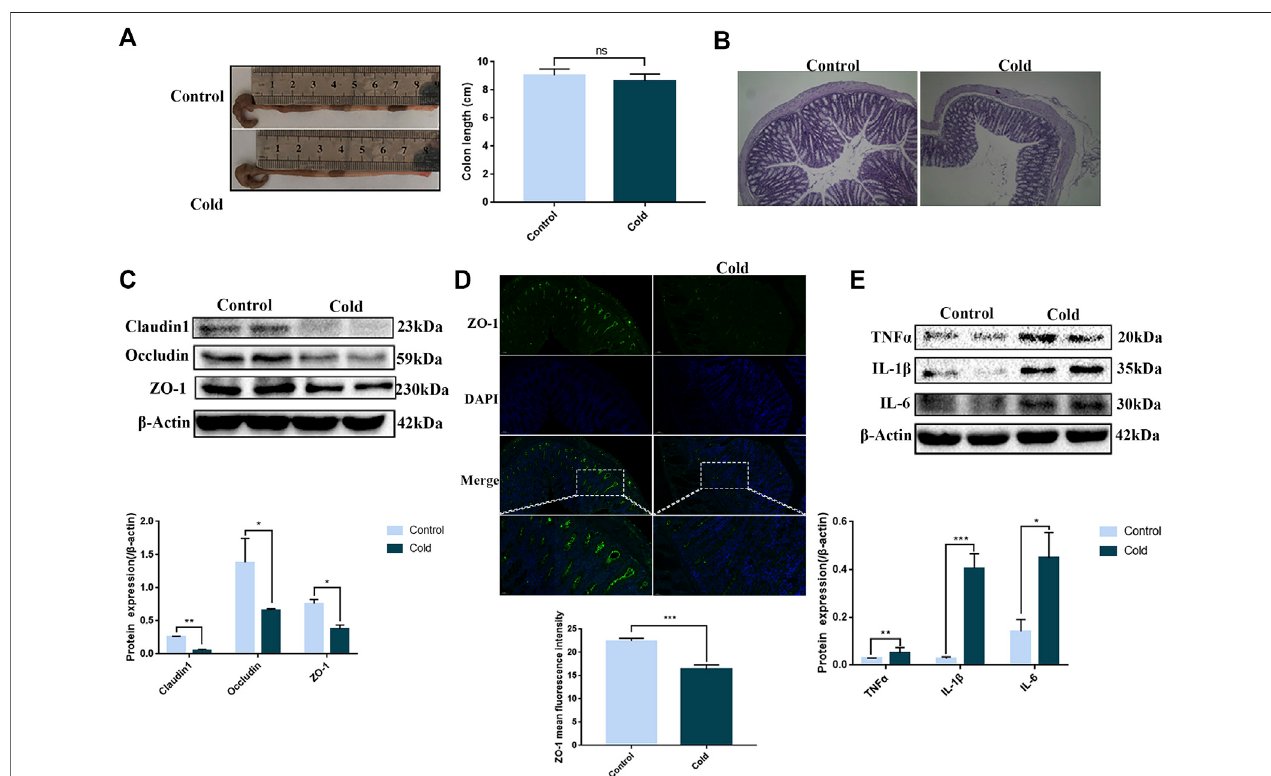
FIGURE1| Coldexposureinducestightjunctiondamageinthecolonandpromotescolonicin fl ammation.Effectsofcoldexposureonmousecolonlength (A) and morphologybyH&Estaining(×100) (B) .Effectsofcoldexposureontheproteinexpressionlevelsofclaudin-1,occludinandZO-1wereassessedbywesternblotanalysis (C) and the expression levels of ZO-1 were determined by immuno fl uorescence staining (D) in the mouse colon. (E) Protein expression levels of TNF α , IL1 β , and IL-6 wereassessedbywesternblotanalysisinmousecolontissue.Dataarepresented asthemean±SEM( n =3).Statisticallysigni fi cantdifferencesareindicated;* p < 0.05, ** p < 0.01, *** p < 0.001, signi fi cantly different from control